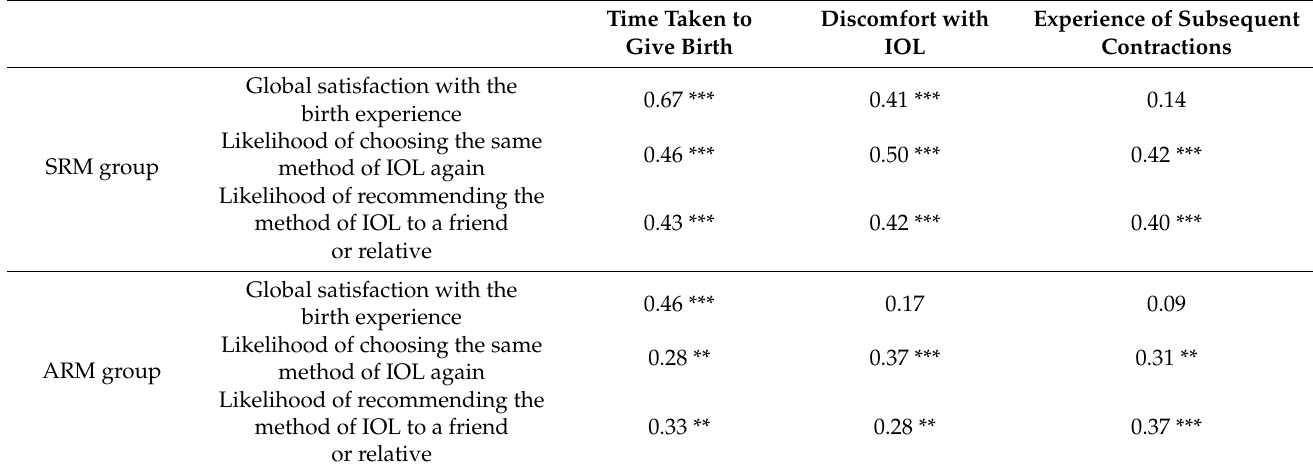
Table 4. Correlations between the EXIT-French subscales and global satisfaction, likelihood of choosing the same method of IOL again, and recommending the method. Time Taken to Discomfort with Experience of Subsequent Give Birth IOL